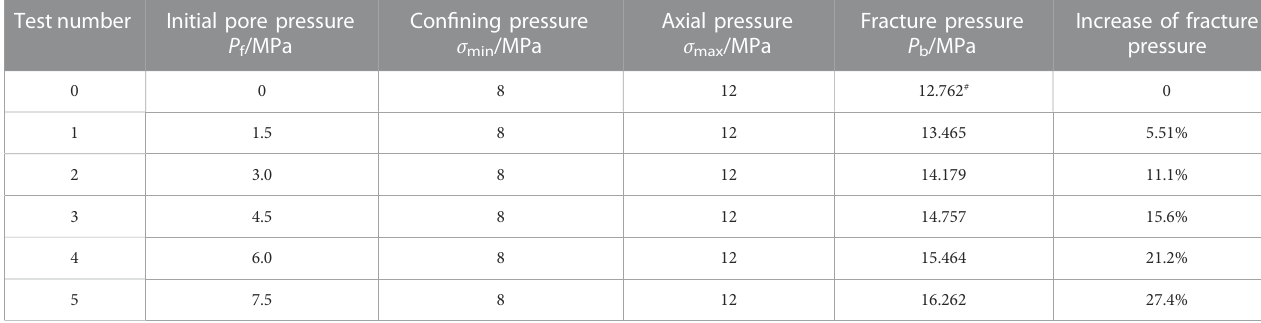
TABLE 2 Pressure environment and corresponding fracture pressure of rock samples in the experiment.